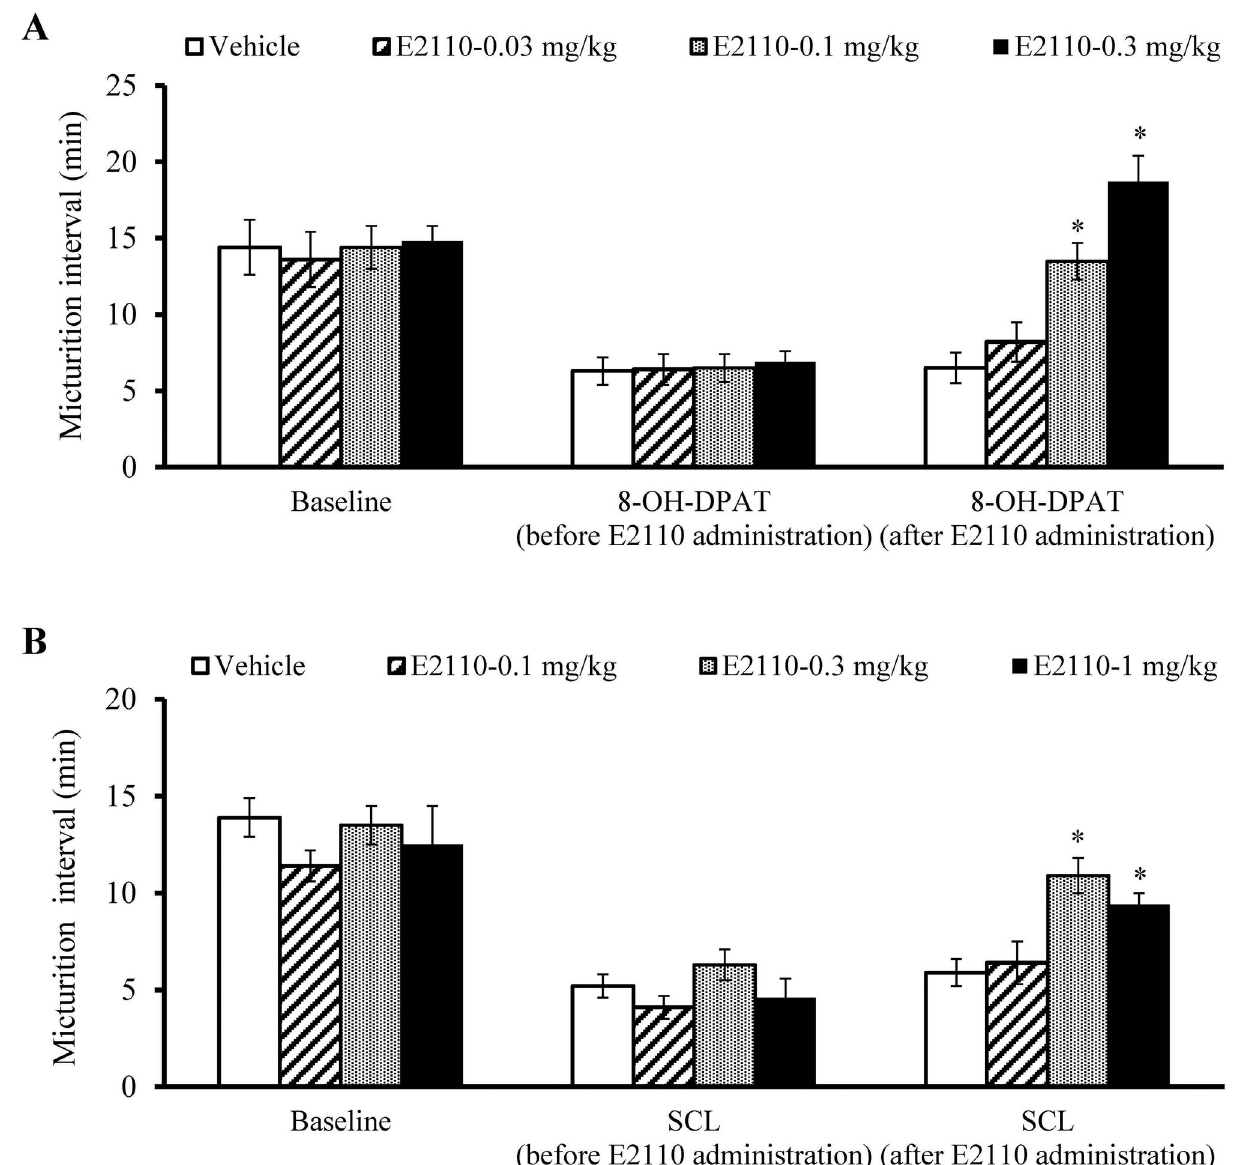
Figure 9. Effects of E2110 on micturition interval in 8-OH-DPAT-infused (A) and SCL (B) rats. Values are expressed as mean ± S.E.M. of eight rats in 8-OH-DPAT-infused and SCL models; * P < 0.05 versus vehicle (Dunnett’s multiple test).